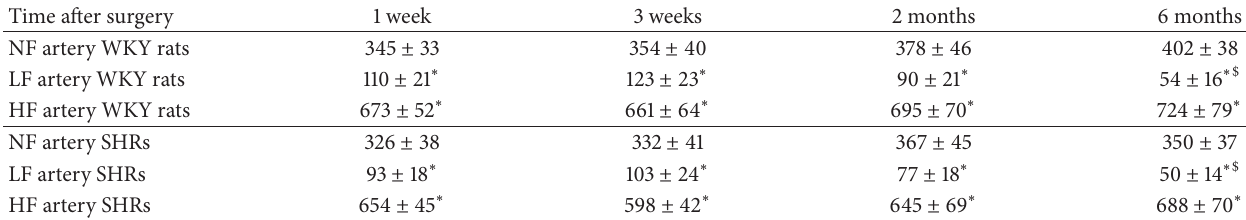
Table 1: Blood flow ( 𝜇 L/min), measured using a Transonic probe in NF, LF, and HF arteries of WKY rats and of SHRs. Time after